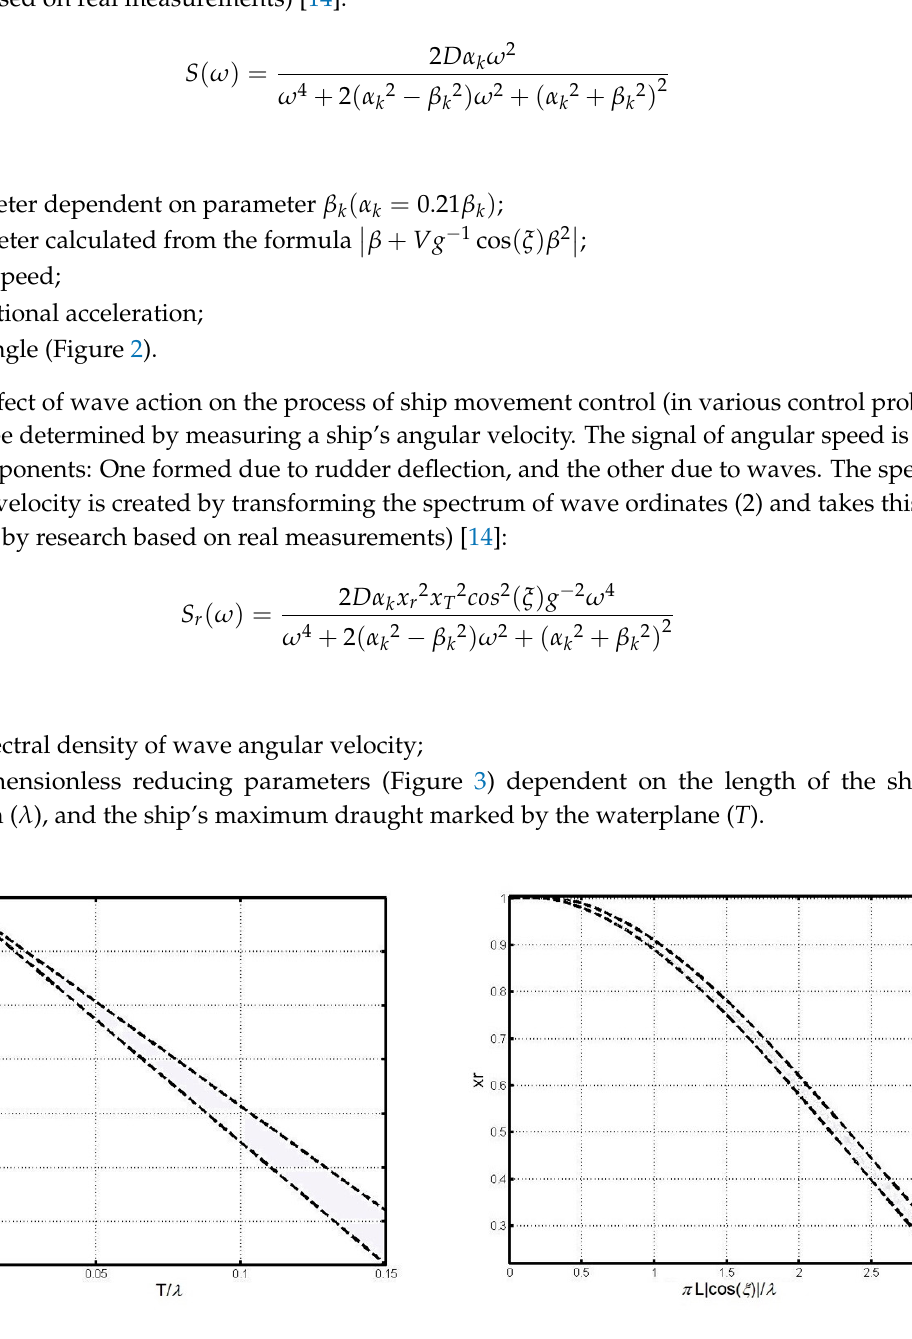
Figure 3. Boundary dependences of reducing parameters.